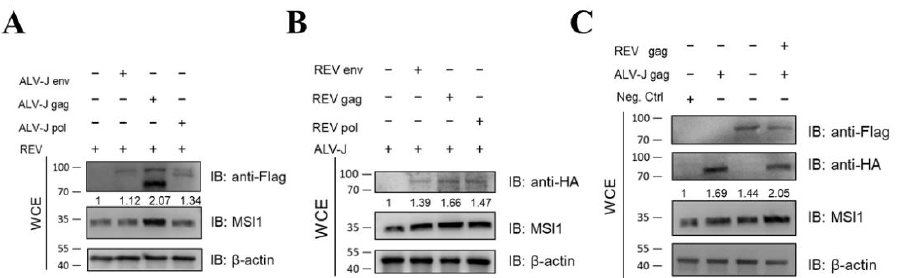
Figure 7. Structural proteins from ALV-J and REV synergistically activate MSI1. ( A ) ALV-J env, gag, and pol activated MSI1 protein expression level in DF-1 infected REV at 48 hpi, as detected using WB. Among the three viral structural proteins, ALV-J gag showed the most significant promotion effect on MSI1 protein expression. ( B ) REV env, gag, and pol activated MSI1 protein expression level in DF-1 infected ALV-J at 48 hpi, as detected using WB. Among the three viral structural proteins, REV gag showed the most significant promotion effect on MSI1 protein expression. ( C ) ALV-J gag and REV gag synergistically activated MSI1 protein expression level in CEF cells at 48 hpi, as detected using WB.